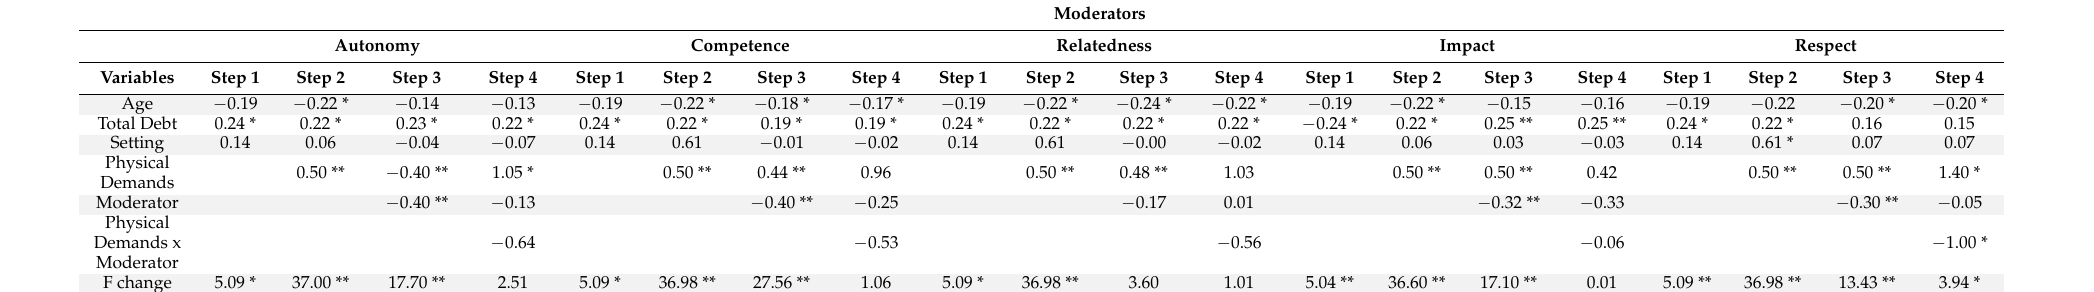
Table 5. Associations between job resources and physical demands with regard to